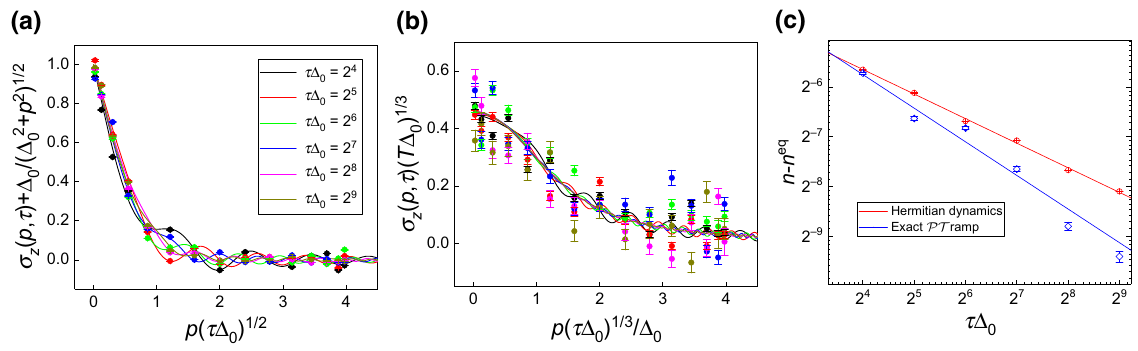
FIG. 2. The Kibble-Zurek scaling of defect production for parametric ramps in Hermitian and non-Hermitian exact PT systems. The data collapse for the momentum-resolved defect density for (a) the Hermitian case and (b) the exact PT ramp. The dots with error bars display the experimental measurements and solid lines refer to numerical simulations. (c) The total defect density n relative to the adiabatic values n eq for the two considered cases as a function of the ramp time τ . The solid lines show the results for the best power- law fit n − n eq ∼ τ − α to the experimental data. The fitted exponents α = 0.494 ( 2 ) for the Hermitian scaling (red) and α = 0.68 ( 1 ) for the exact PT ramp